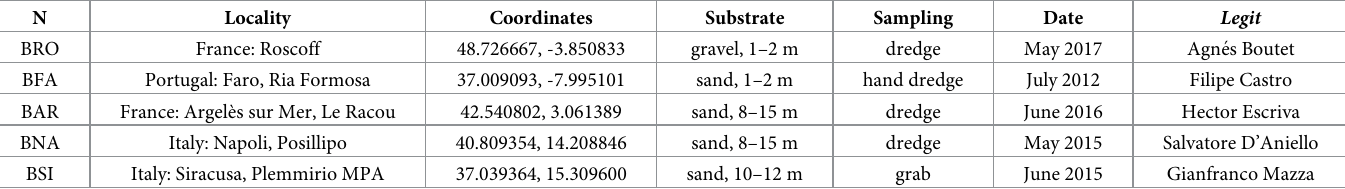
Table 1. Sampling sites (codes as in Fig 1) with geographic coordinates (WGS 84), environmental data, sampling gear, date, and legit . N